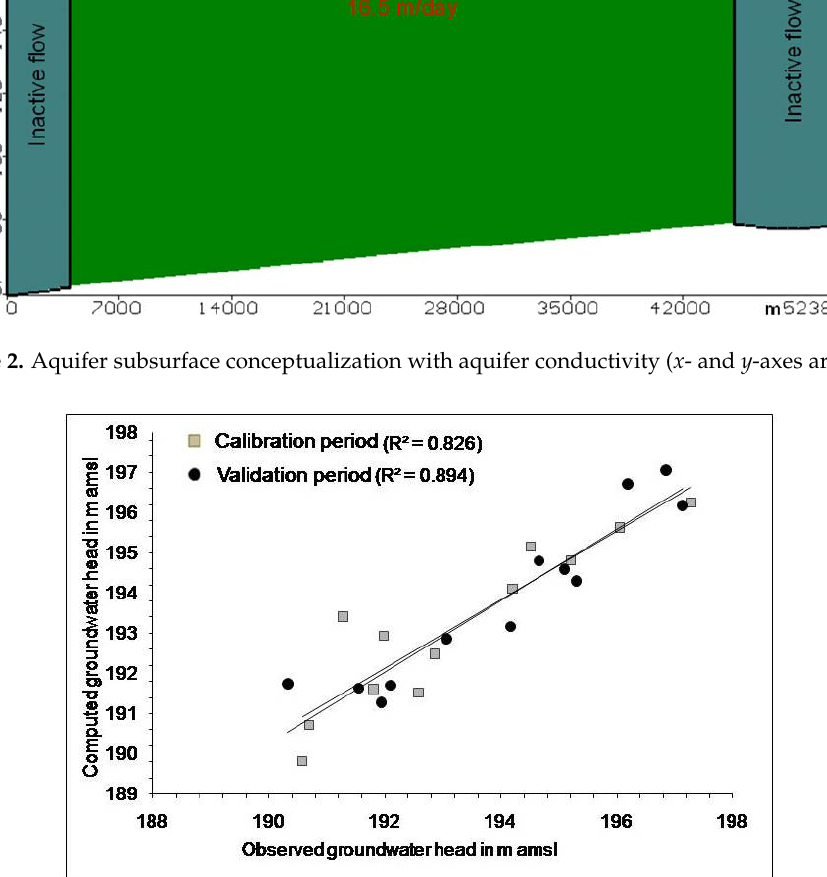
Figure 3. Spatially distributed observed and computed heads during calibration (2005–2008) and validation (2009–2011).